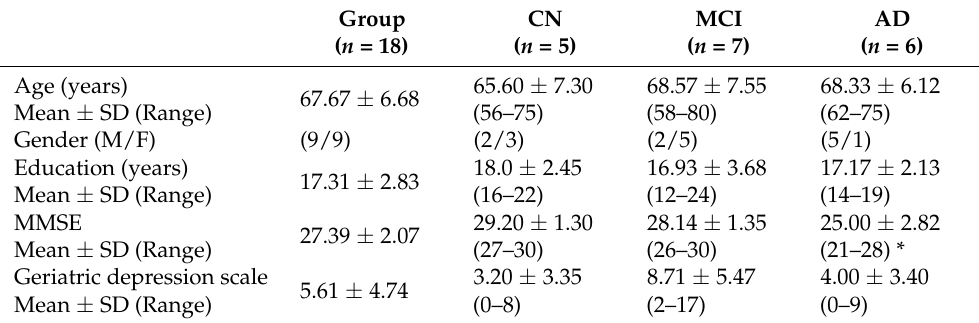
Table 1. Participants’ baseline characteristics receiving oral appliance therapy plus mouth